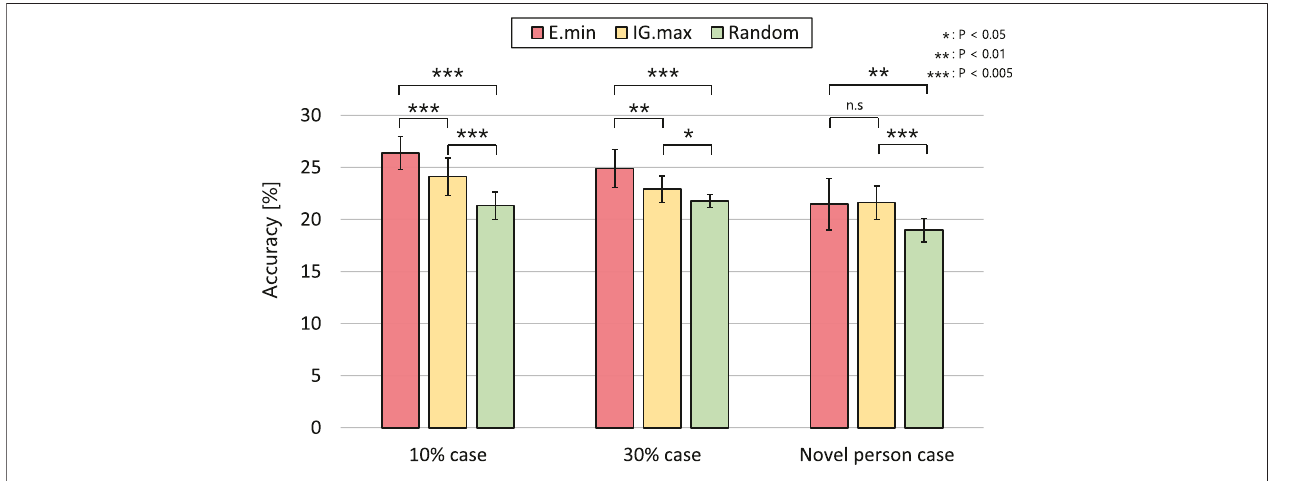
FIGURE 8 | Estimation accuracy for the fi rst active perception executed in each dataset case.